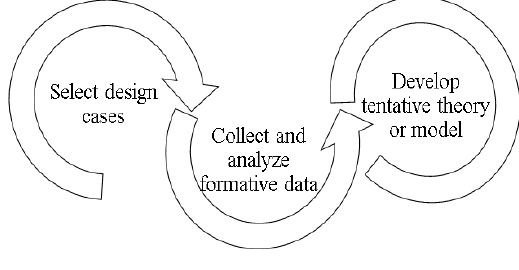
Figure 1 . The steps of in vivo naturalist formative research.